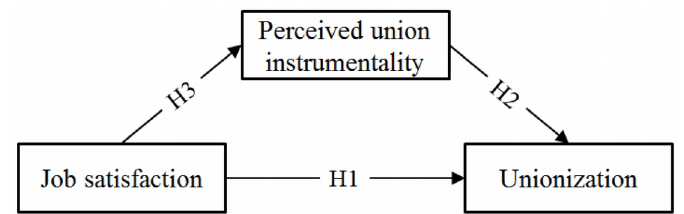
Figure 1. Conceptual model of job satisfaction and